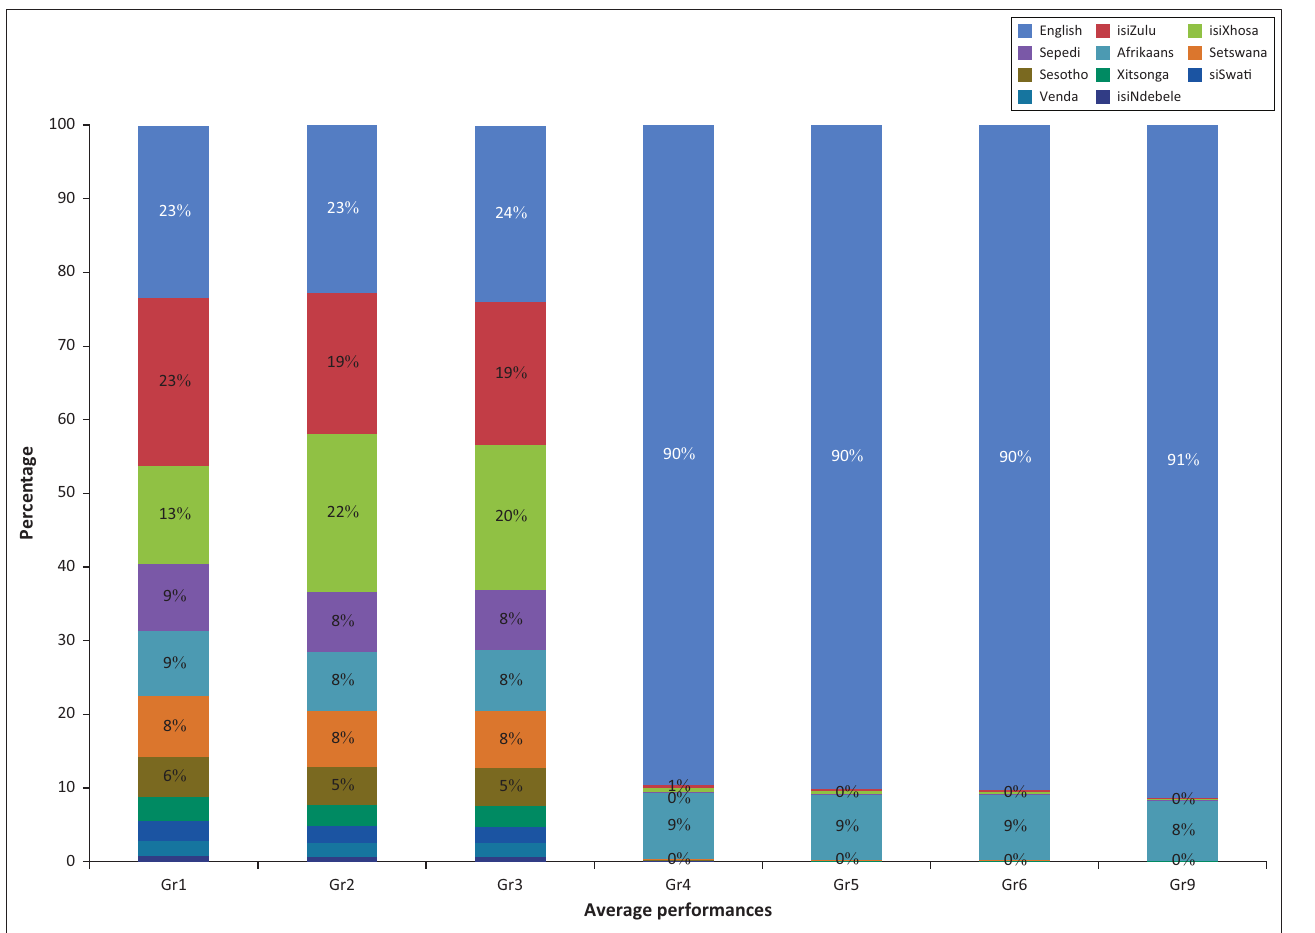
FIGURE 1: Breakdown of language of learning and teaching (LOLT) by grade – Annual National Assessments 2013 ( n = 7 630 240, own calculations using